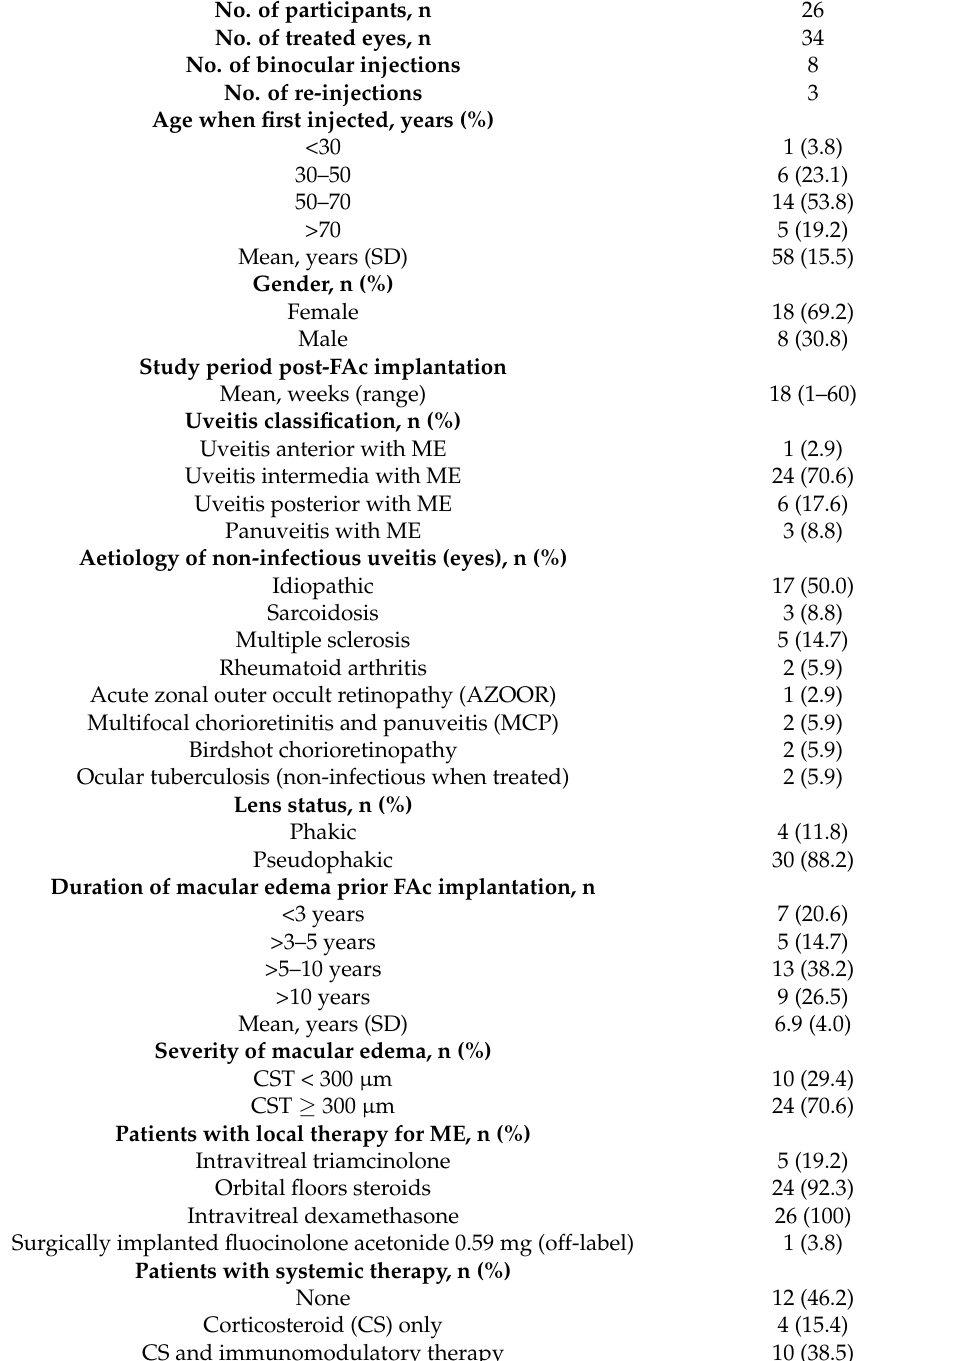
Table 1. Baseline